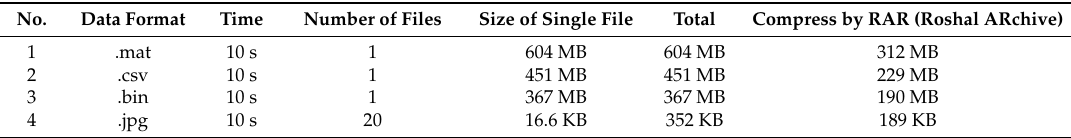
Table 3. Comparison of data file sizes in different